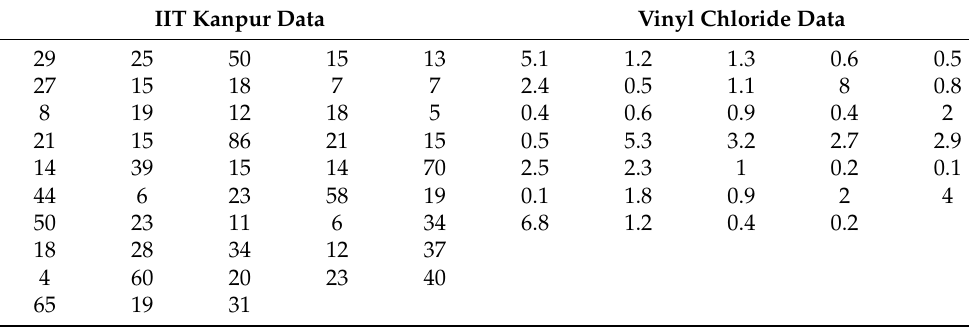
Table 4. IIT Kanpur and vinyl chloride data sets investigated in Section 4.2. IIT Kanpur Data